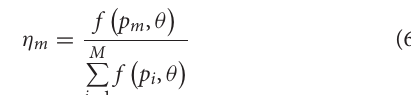
interest rate of 1-year cash deposits is 1.5%, while that of 1-year bank loans in the same period is 4.35%. The ratio between the